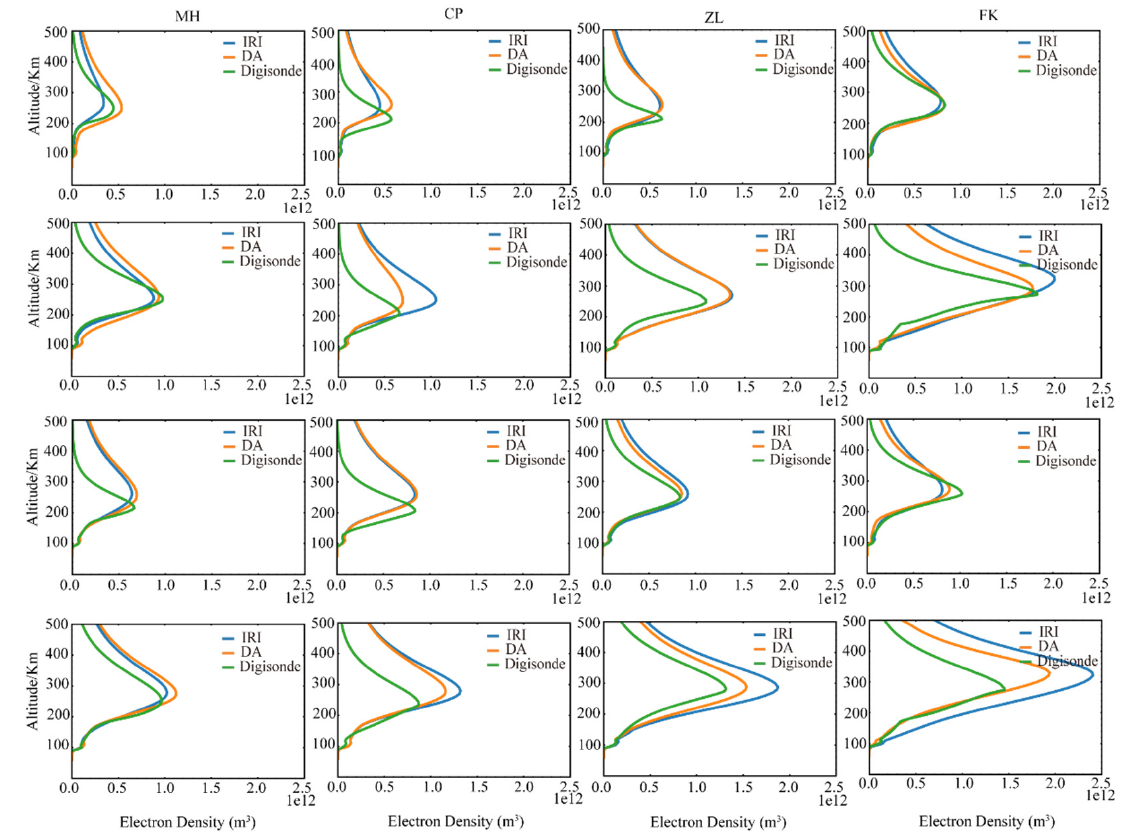
Figure 7. Comparison of ionospheric electron density profiles. The green curve is the observational result of digisondes, the blue curve is the IRI modeling results, and the orange curve shows the assimilation results. The first and second rows are the electron-density profile contrast diagram at 00:00 UT and 06:00 UT on 1 January 2015, respectively. The third and fourth rows show the electron-density profile contrast diagram at 00:00 UT and 06:00 UT on 17 March 2015, respectively.